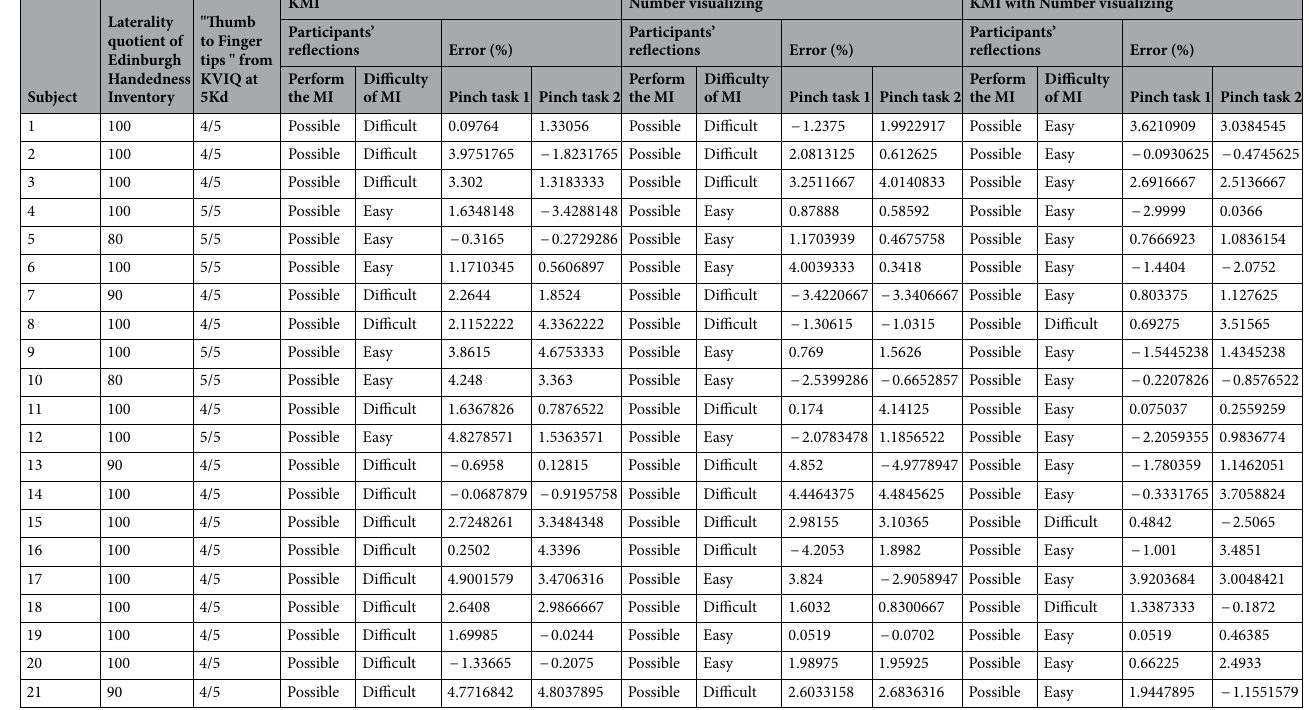
Table 1. Imagination sensitivity and participants’ reflections, and details of error of less than